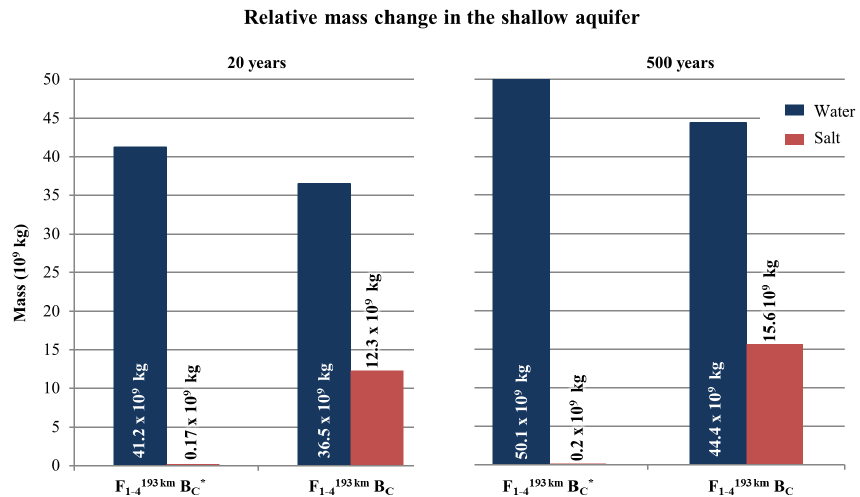
B C with a sharp saltwater– 1 − 4 B ∗ with salinity increasing with depth by 0.23gkg − 1 1 − 4 C